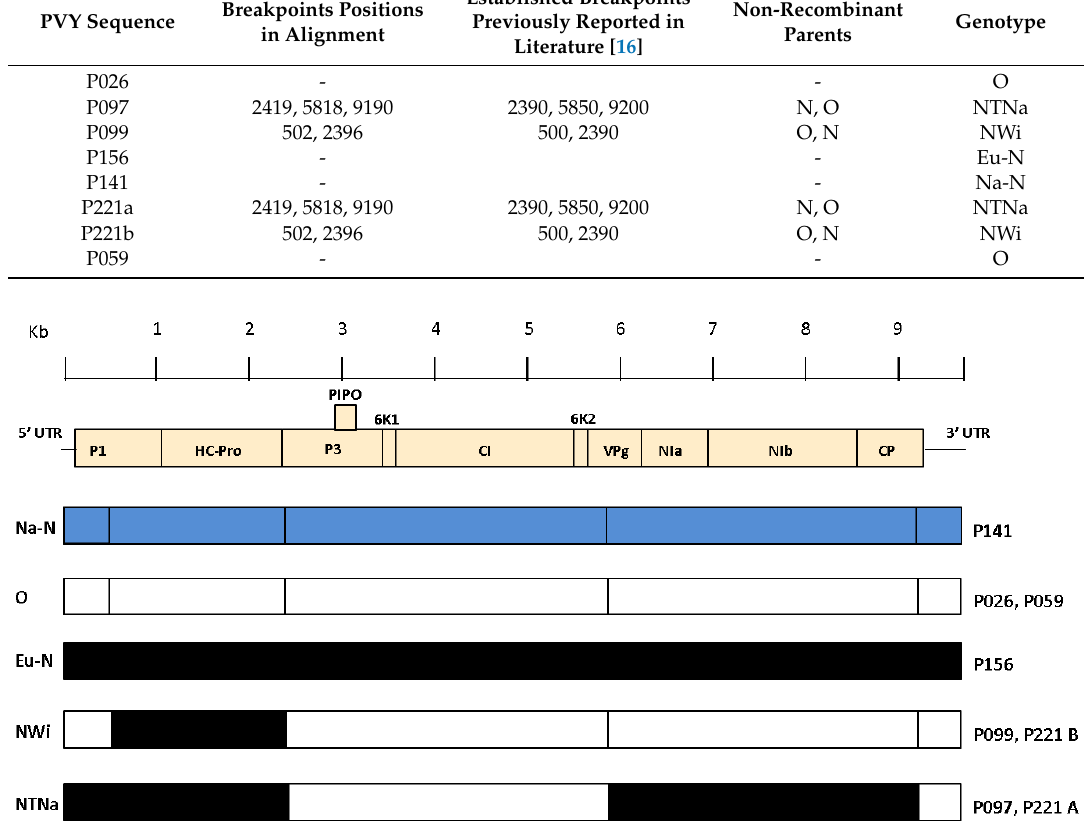
Figure 4. Schematic representation of the genetic structures of PVY isolates sequenced in this study. A di ff erent color (blue, white and black) is assigned to each non-recombinant genotype, recombinant genotypes are colored accordingly. Names of the PVY genotypes are listed on the left side of Figure, while the corresponding isolates are listed on the right. The breakpoints in the alignment related to the identified recombinant genotypes are marked with vertical black bars. PVY genome (~9.7 Kb) is drawn at the top, with cistrons represented as rectangles with the corresponding protein